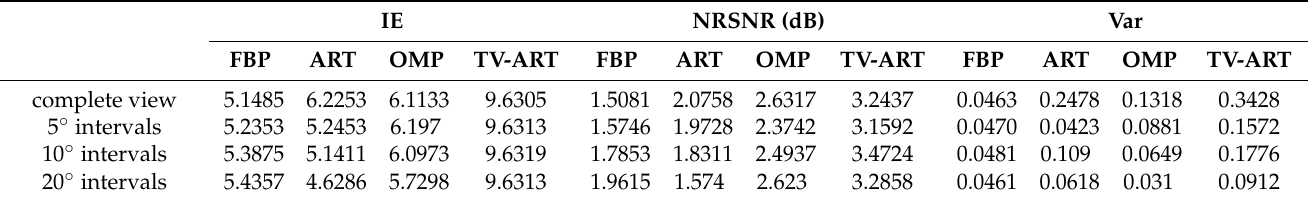
Table 1. Comparison of the metric values of the results by using different algorithms.